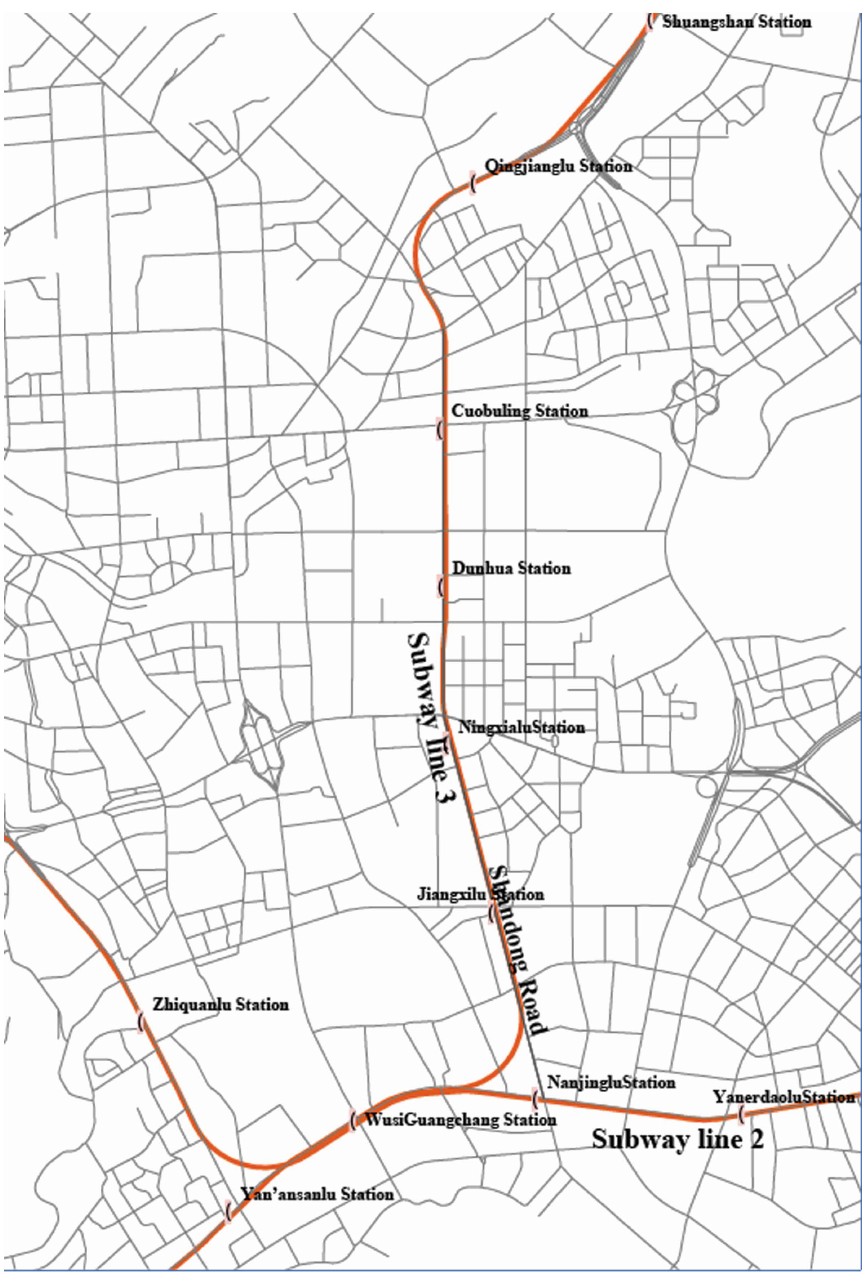
Figure 14: Shandong Road and Metro line